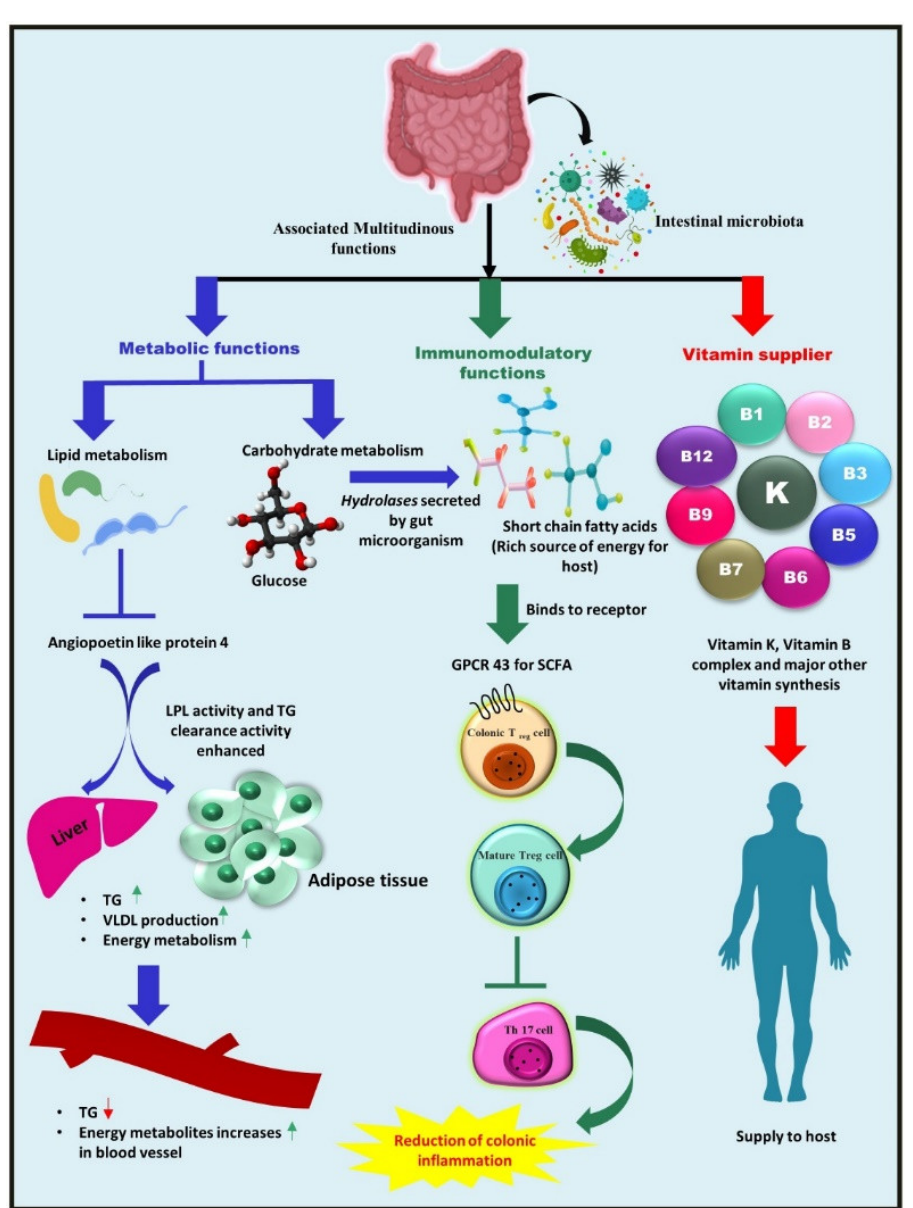
Figure 1. Summary of the gut microbiota-associated functioning in the human body. The gut microbiota leads to enhanced lipid clearance by repressing angiopoietin-like protein 4 (Angptl4), an inhibitor of LPL, due to which energy metabolites are elevated in the serum, which is demonstrated by an increase in associated genes in the liver transcriptome. Triglyceride levels in the serum are reduced while they rise in adipose tissue and in the liver. Dietary carbohydrates are metabolized into SCFAs, a rich energy source for the host by colonic bacteria by employing a special class of enzyme, hydrolases. Furthermore, these SCFAs, especially butyrate, can provoke the GPCR 43 expressed by intestinal epithelial cells and regulate the development, differentiation, and maturation of Treg cells via epigenetic regulation, resulting in the inhibition of Th17 cell development and the reduction of colonic inflammation. Selected gut microbiota can also act as vitamin suppliers to the host, as they synthesize vitamin B complexes and vitamin K and supplies them to the host.